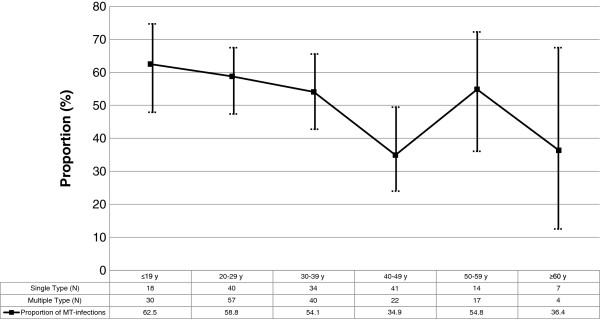
Age stratified proportion of multiple-type HPV infections (95% confidence intervals displayed in vertical bars).